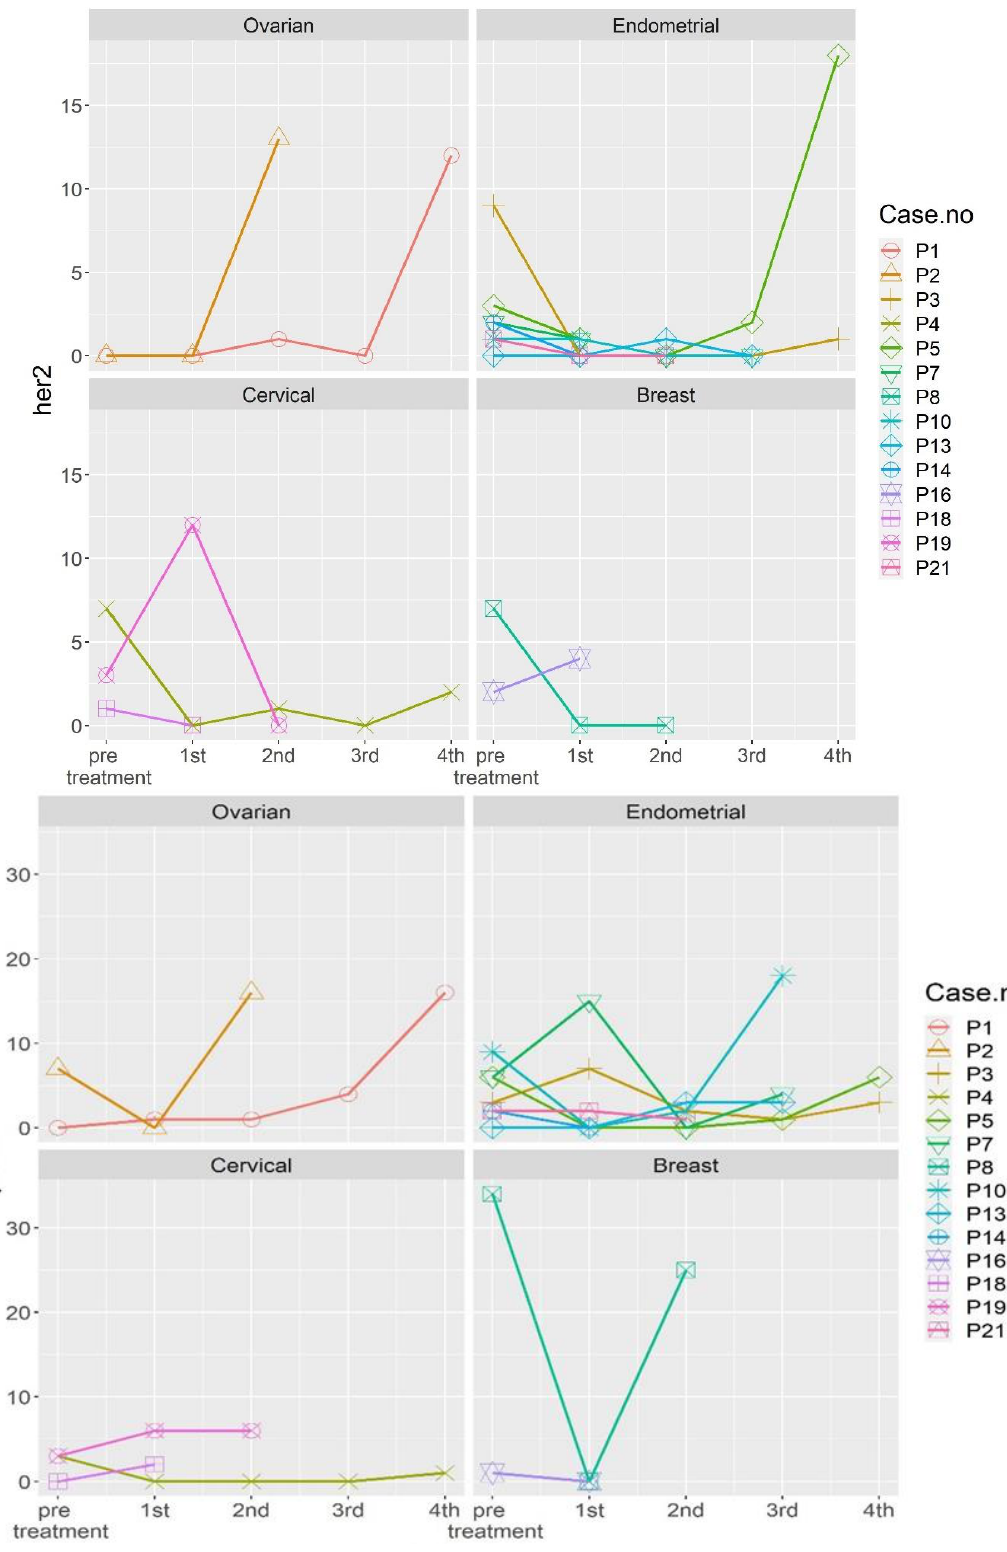
Figure 2. Dynamic changes in the expression of different molecular markers in the 17 patients before and after treatment. Abbreviations: P1, Patient 1; P2, Patient 2; P3, Patient 3; P4, Patient4; P5, Patient 5; P7, Patient 7; P8, Patient 8; P10, Patient 10; P13, Patient 13; P14, Patient 14; P16, Patient 16; P18, Patient 18; P19, Patient 19; and P21, Patient